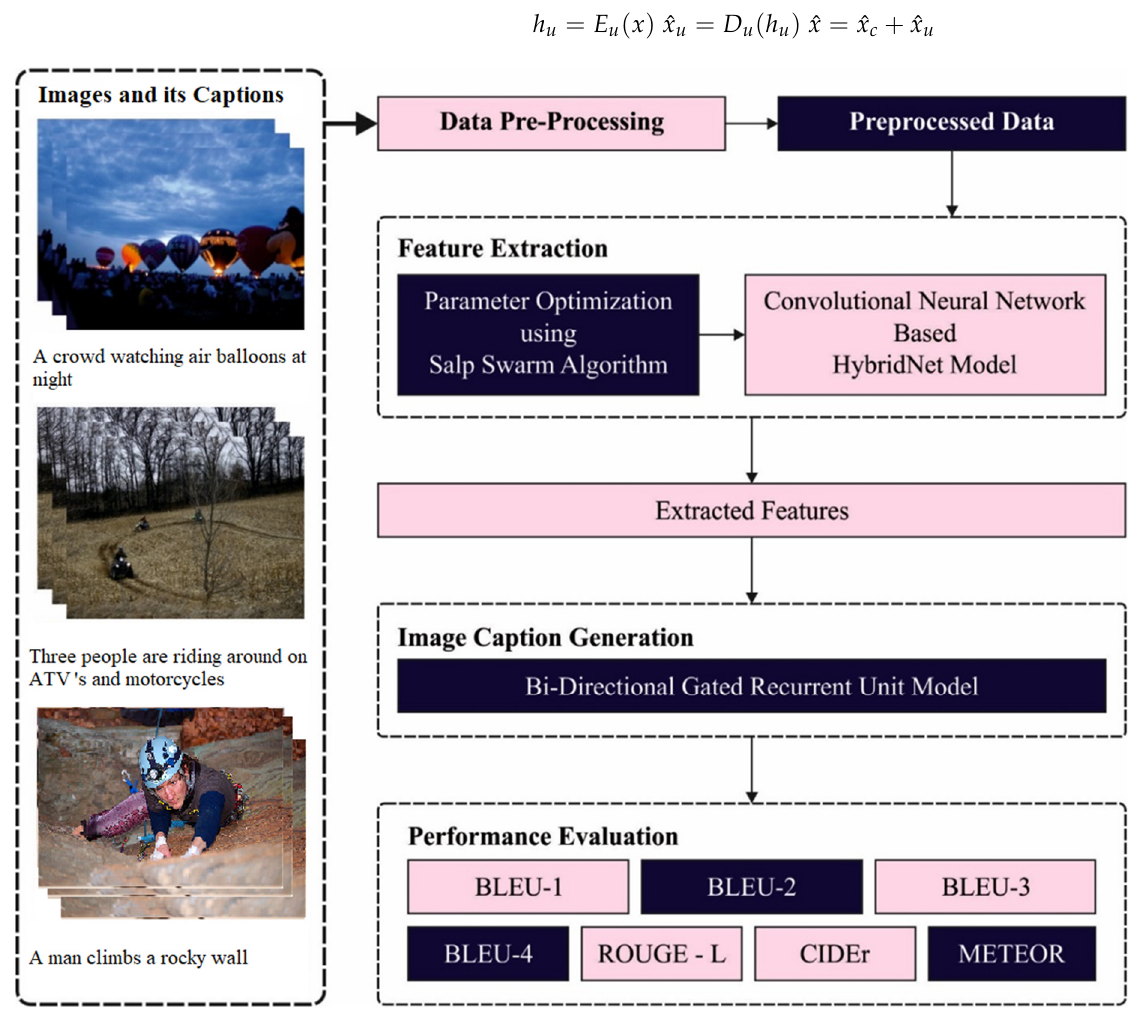
Figure 1. Block diagram of MODLE-AICT approach.